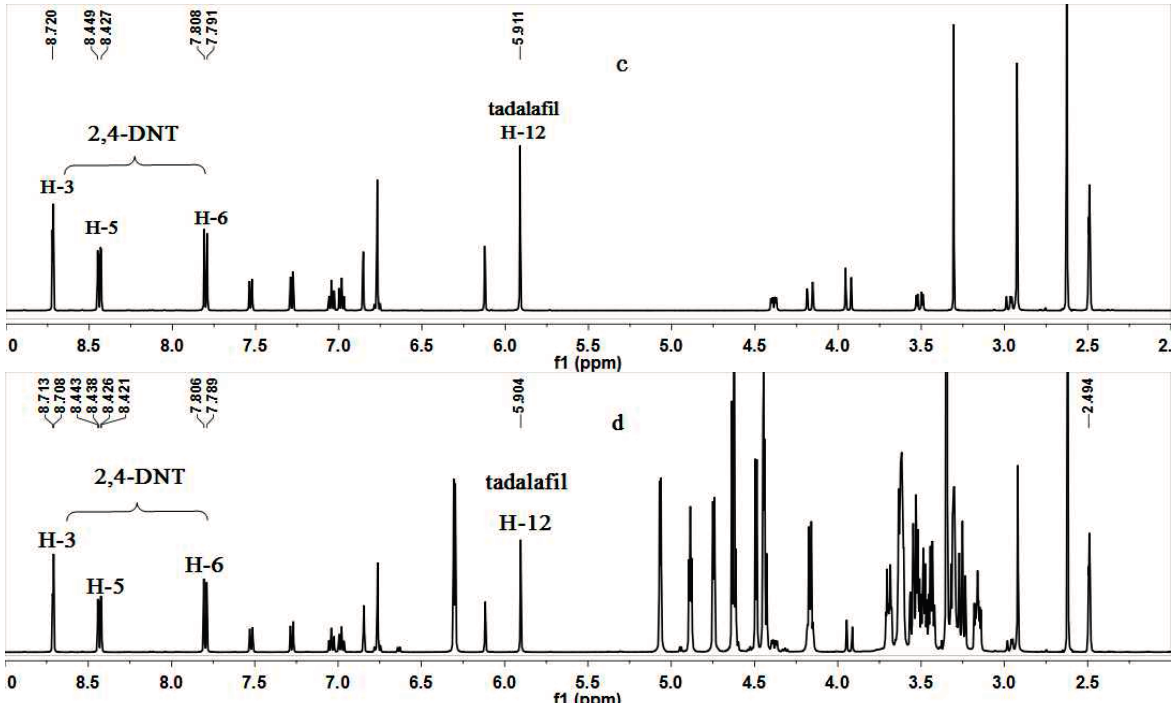
Figure 1. ( a ) 1 H-NMR spectra of tadalafil in dimethylsulfoxide (DMSO). ( b ) 1 H-NMR spectra of 2,4-dinitrotoluene (2,4-DNT) in DMSO. ( c ) 1 H-NMR spectra of the mixture of tadalafil and 2,4-DNT in DMSO. ( d ) 1 H-NMR spectra of the mixture of tadalafil, 2,4-DNT and tadalafil tablet powder in